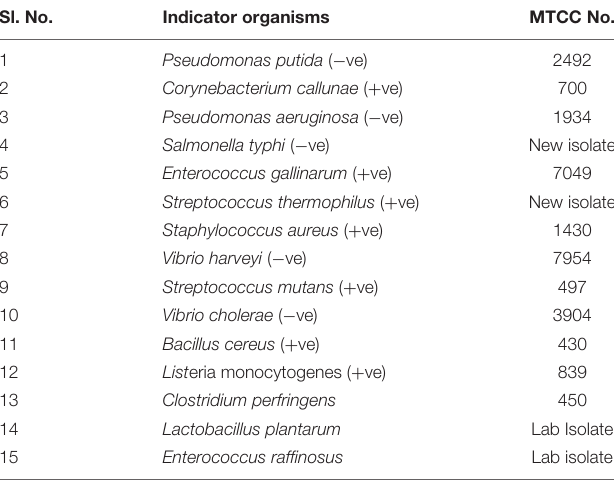
TABLE 1A | Strains used for the study. Sl.